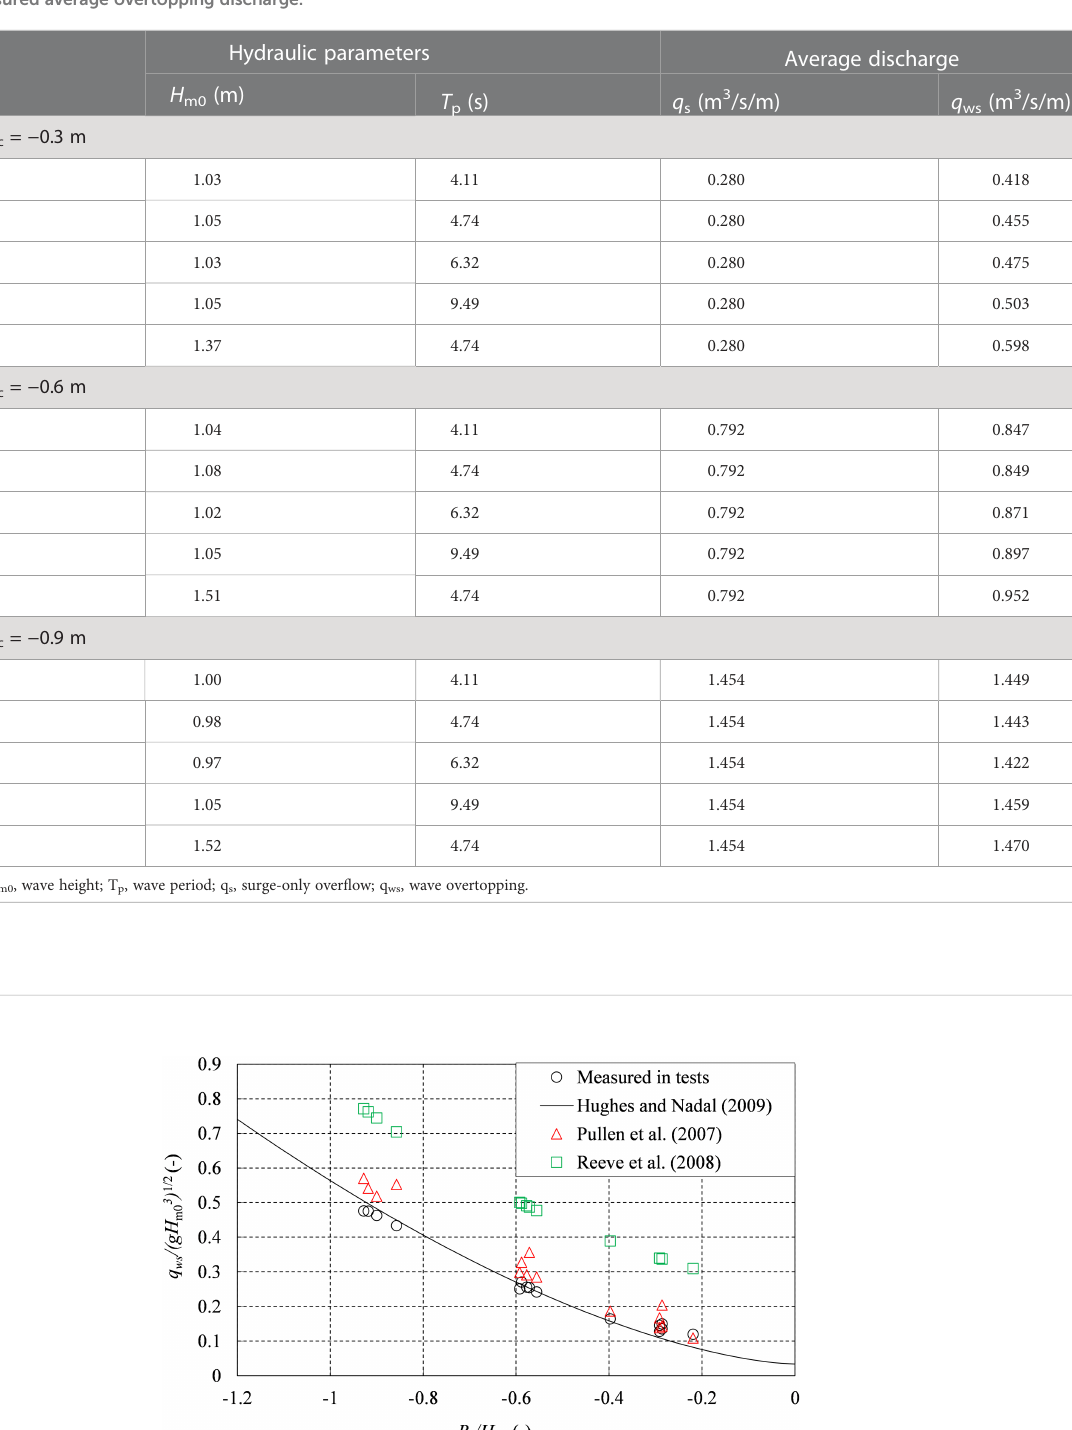
TABLE 2 Measured average overtopping discharge.